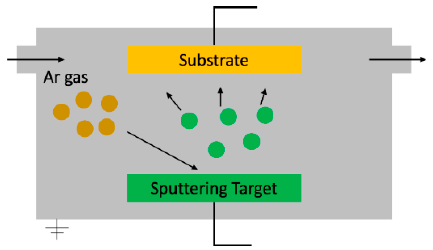
Figure 9. Schematic diagram of a sputtering system showing the basic components and operation.